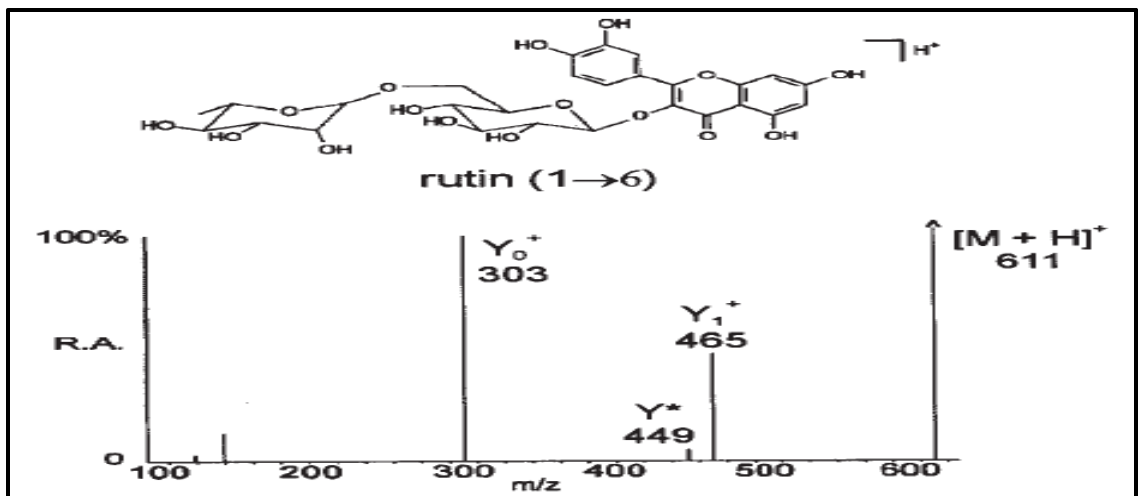
Figure 13. Mass spectrum of rutin in ethyl acetate fraction